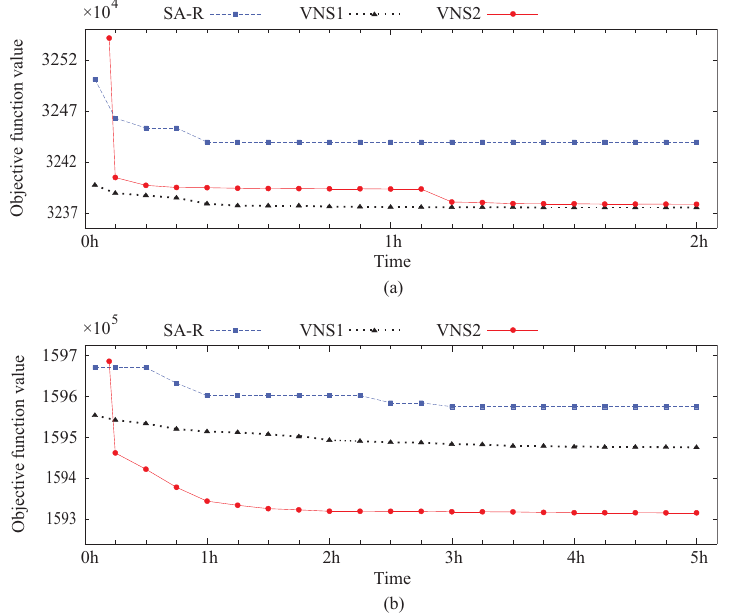
Figure 9. Convergence speed of SA-R, VNS1, and VNS2: ( a ) p-100-5 ; and ( b ) p-200-3